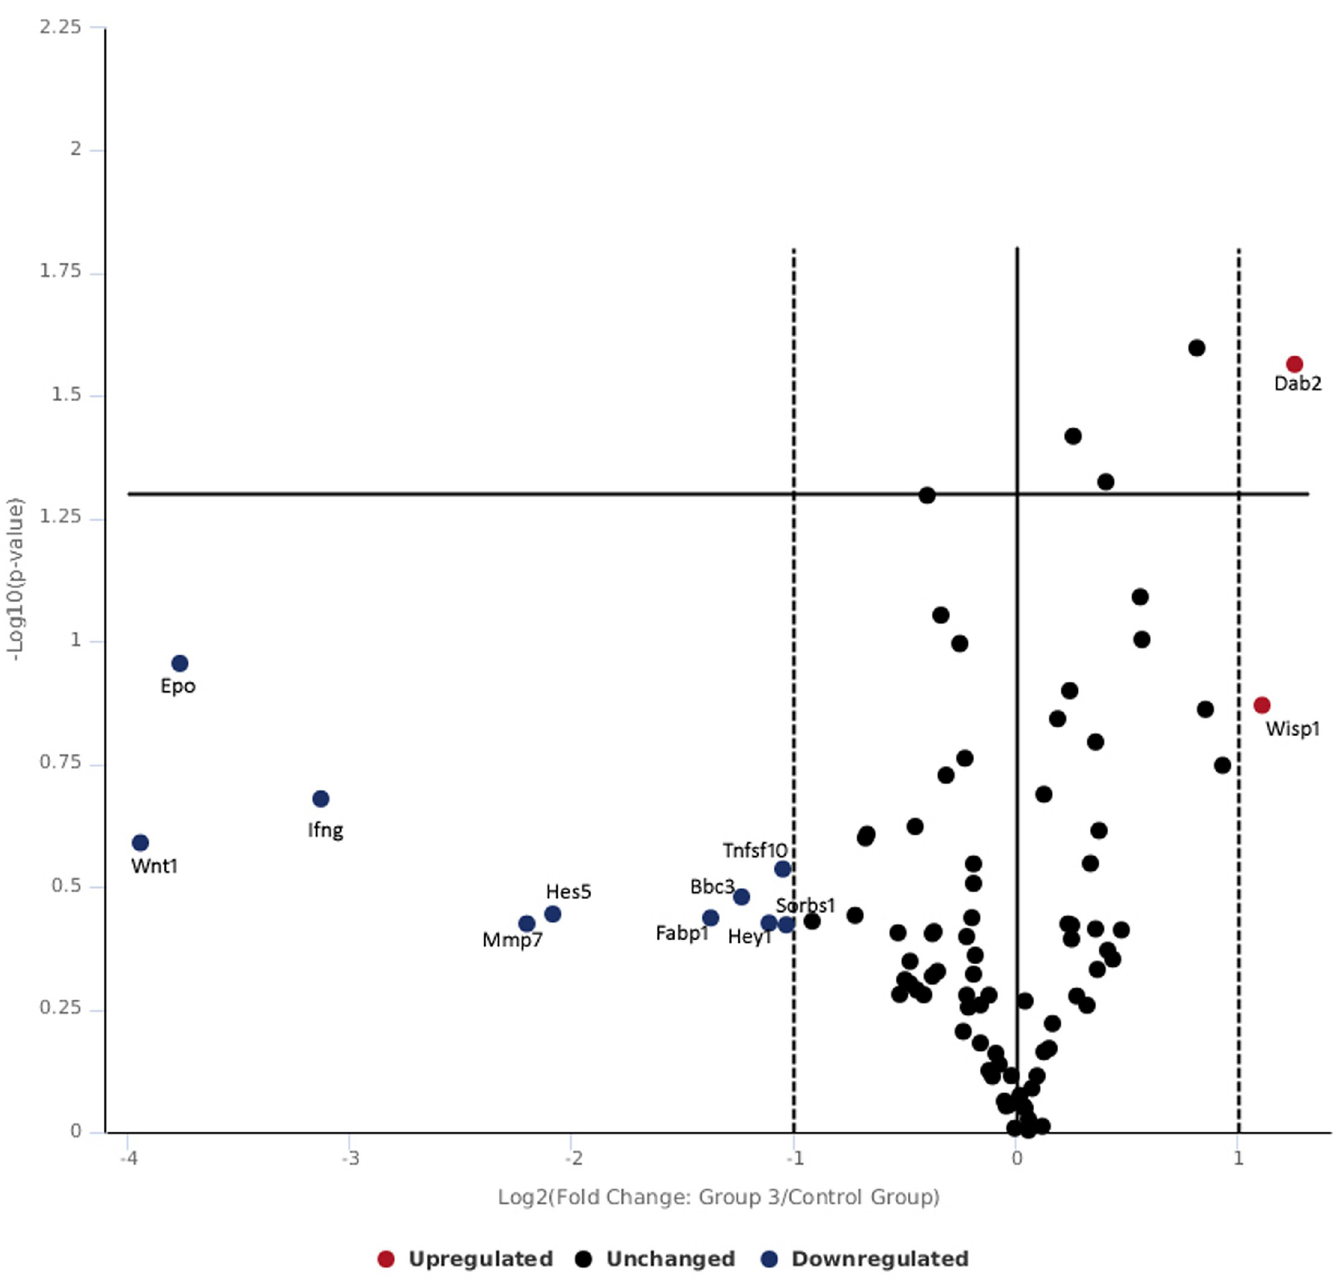
Fig 5. Volcano plot of genes expressed following 532 nm laser exposure at high radiance of 0.5 W/cm 2 .